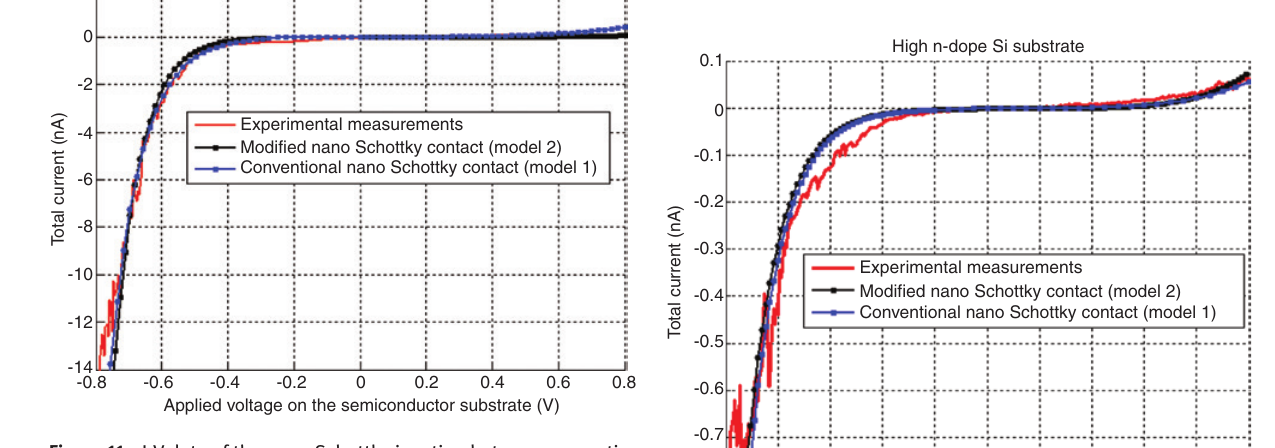
Figure 11: I-V data of the nano-Schottky junction between a nanotip and a high n-doped semiconductor substrate.